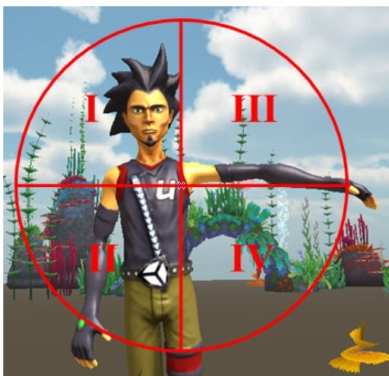
Figure 6. Mirrored coordinate system and four quadrants (I, II, III and IV) of the reachable workspace of the